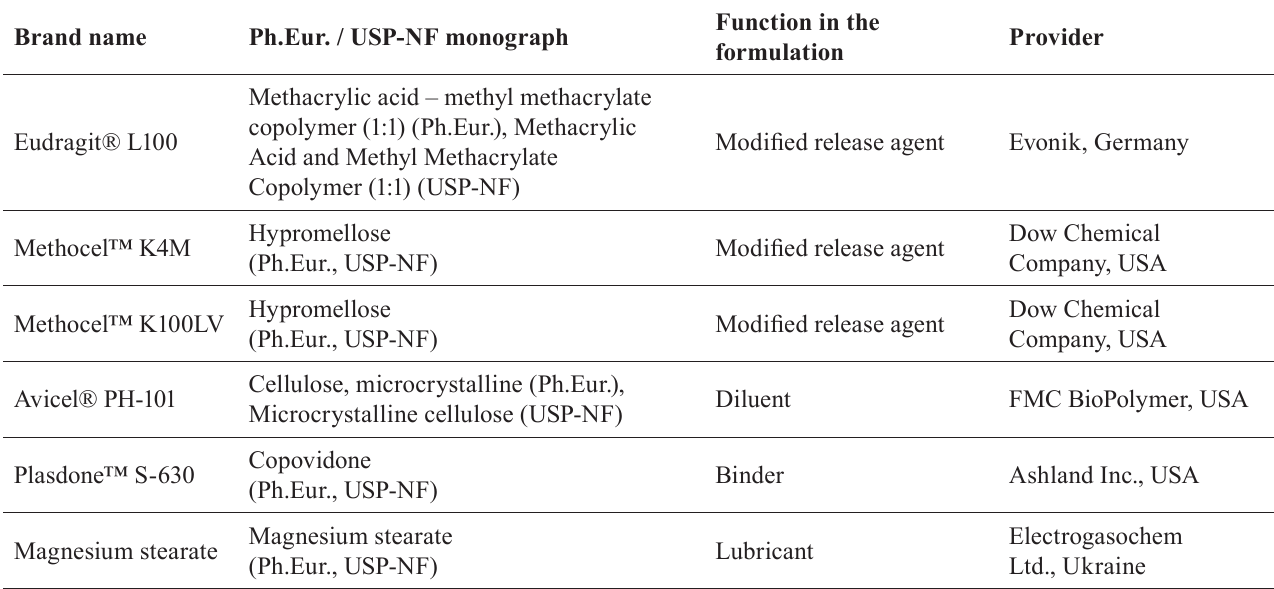
TABLE I – P harmaceutical excipients used in the compatibility